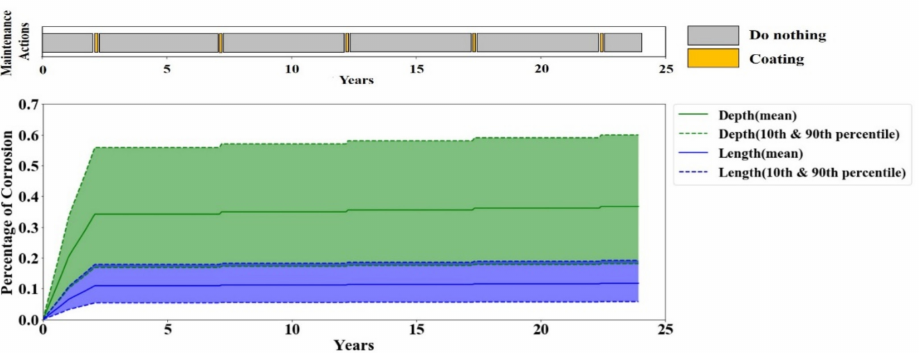
Figure 8. Corrosion depth and length in one full-life evaluation episode by Q-learning.